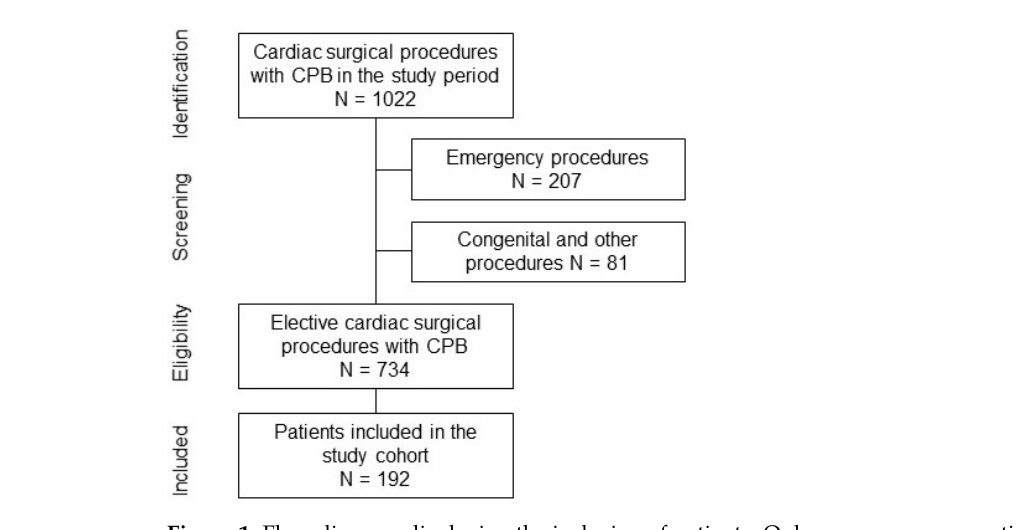
Figure 1. Flow diagram displaying the inclusion of patients. Only non-emergency patients undergo- ing cardiac surgery with the use of cardiopulmonary bypass (CPB) were included. The inclusion was limited by the operating hours of the institutional biobank, accepting blood samples between 8 a.m. and 4:30